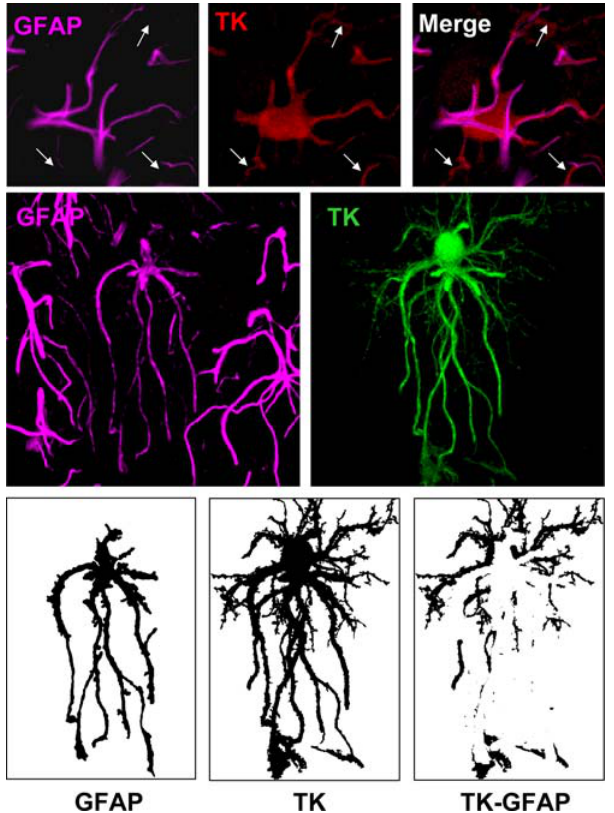
Figure 1. Immunocytochemistry for TK reveals the full extent of infected astrocyte morphology compared to GFAP. Confocal images show double staining of TK and GFAP in rat brain sections. The top row shows that TK and GFAP stain different structures and processes of the same cell. Arrows indicate processes that are TK + but not GFAP + . The middle row shows a TK + cell which is also GFAP + . Note that TK staining reveals more processes, and a fuller cell body than GFAP. In the lower row we show the optical segmentation of TK, GFAP and the non-overlapping area (GFAP image subtracted from TK image). The result shows the TK + processes that are not GFAP + . This demonstrates that TK provides a fuller image of infected astrocytes.